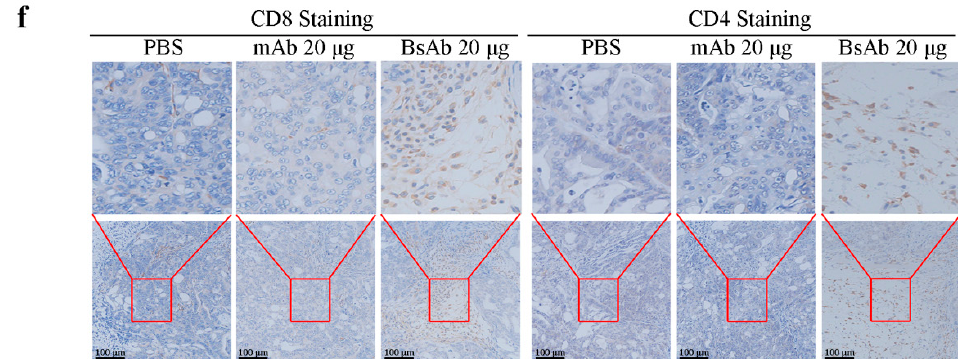
Figure 6. In vivo anti-tumor activity of m3s193 mAb and m3s193 BsAb. Mice were treated i.v. with PBS, mAb (20 µ g), and BsAb (0.8, 4, 20 µ g) on day 0, twice a week, 6 times. ( a ) Individual tumor growth curve with time course. Data are presented as measured tumor volume from each mouse in five groups. ( b ) Mean tumor growth curve with time course. Data are presented as mean ± SD. Statistical significance of experiment groups compared to PBS and mAb group was analyzed by Student’s t-test with two-tailed double sample isovariance hypothesis in Microsoft Excel, and p < 0.05 was considered statistically significant. ( c ) The digital image of stripped tumors. ( d ) Mice body weight of five groups with time course and presented as mean ± SD. ( e ) Weight of stripped tumors in five groups and presented as mean ± SD. Differences between samples were also tested for statistical significance by the same Student’s t-test. ( f ) Representative images of histologic analysis of explanted tumors stained for human CD8 and CD4. In this figure, *, **, and *** mean compared with the PBS group, * p < 0.05, ** p < 0.01, and *** p < 0.001. ##, and ### mean compared with the mAb group, ## p < 0.01, and ### p <